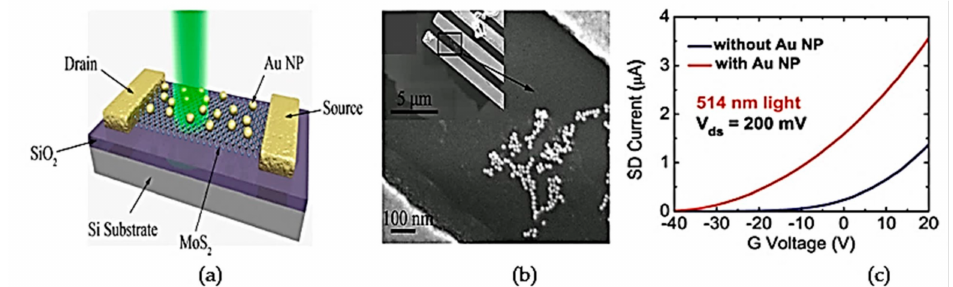
Figure 14. ( a ) Schematic of MoS 2 transistor with Au NPs decoration, ( b ) scanning electron microscopy image of Au NPs on MoS 2 and ( c ) the electrical characteristic of MoS 2 transistor with and without Au NPs (Reprinted from [86], with the permission of AIP Publishing,